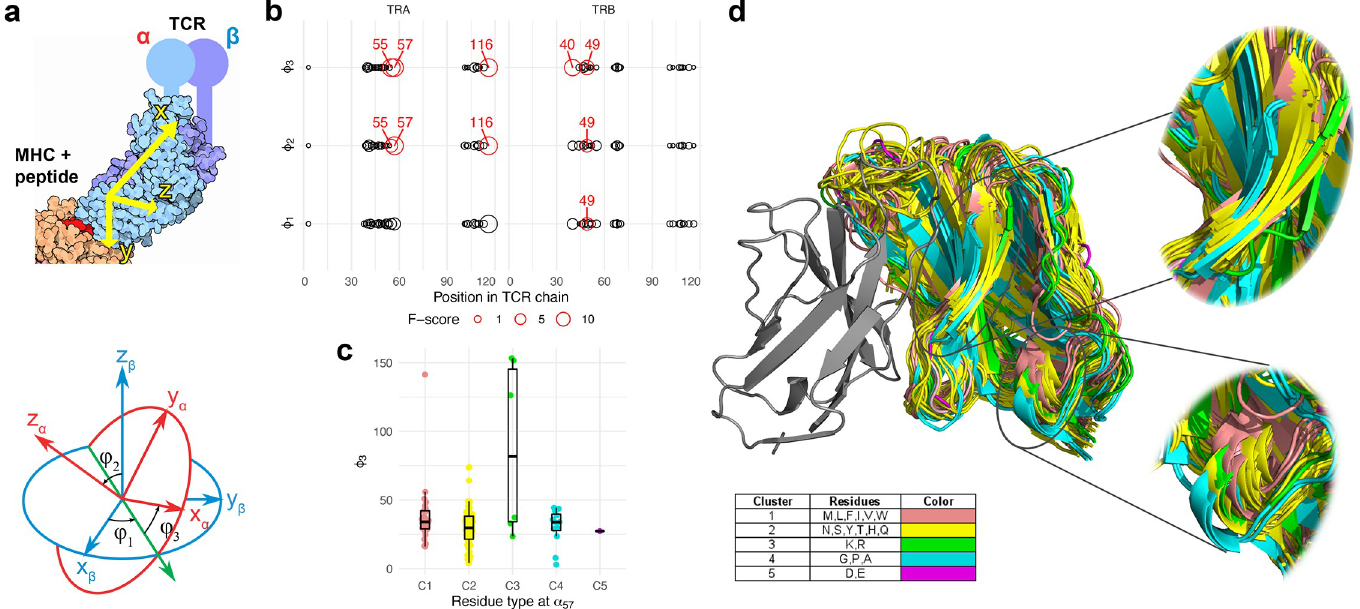
Fig 5. Contacting residues define mutual orientation of chains in TCR αβ complex. a. A schematic definition of angles between α and β chains. Principal axes (x α , y α , z α ) and (x β , y β , z β ) of both TCR chains are computed using the inertia tensor of all atoms of a given chain with the exception of constant domain atoms ( top panel ); representative orientation of principal axes in real TCR:pMHC complex are shown. Euler angles φ 1,2,3 are then computed by superimposing chain centers of mass and computing angles between α and β principal axes ( bottom panel ). Illustrations were adapted from Wikimedia Commons (https://commons.wikimedia.org/wiki/ File:63-T-CellReceptor-MHC.tif by David Goodsell and https://commons.wikimedia.org/wiki/File:Eulerangles.svg by Lionel Brits). b. Testing association between amino acid type (see Methods section and panel d. insert for amino acid cluster definition) and inter-chain angles. Point size shows ANOVA F-score for association between amino acid type and each of three Euler angles across TCR alpha and beta chain positions. The testing is performed for a non-redundant set of TCR chain orientations: all PDB structures with the same V α J α V β J β are collapsed into a single observation with mean φ 1 , φ 2 and φ 3 angles to prevent biases from several complexes with the same TCR. Red circles and labels show contact positions where a significant association between amino acid content and inter-chain angle is present, determined as P < 0.05 (adjusted for multiple testing). c. Representative distribution of φ 3 angle values for each amino acid type at α 57 position. d. Visualization of all PDB structures aligned to a single representative TCR beta chain. TCR alpha chains are colored according to amino acid type at α 57 position.